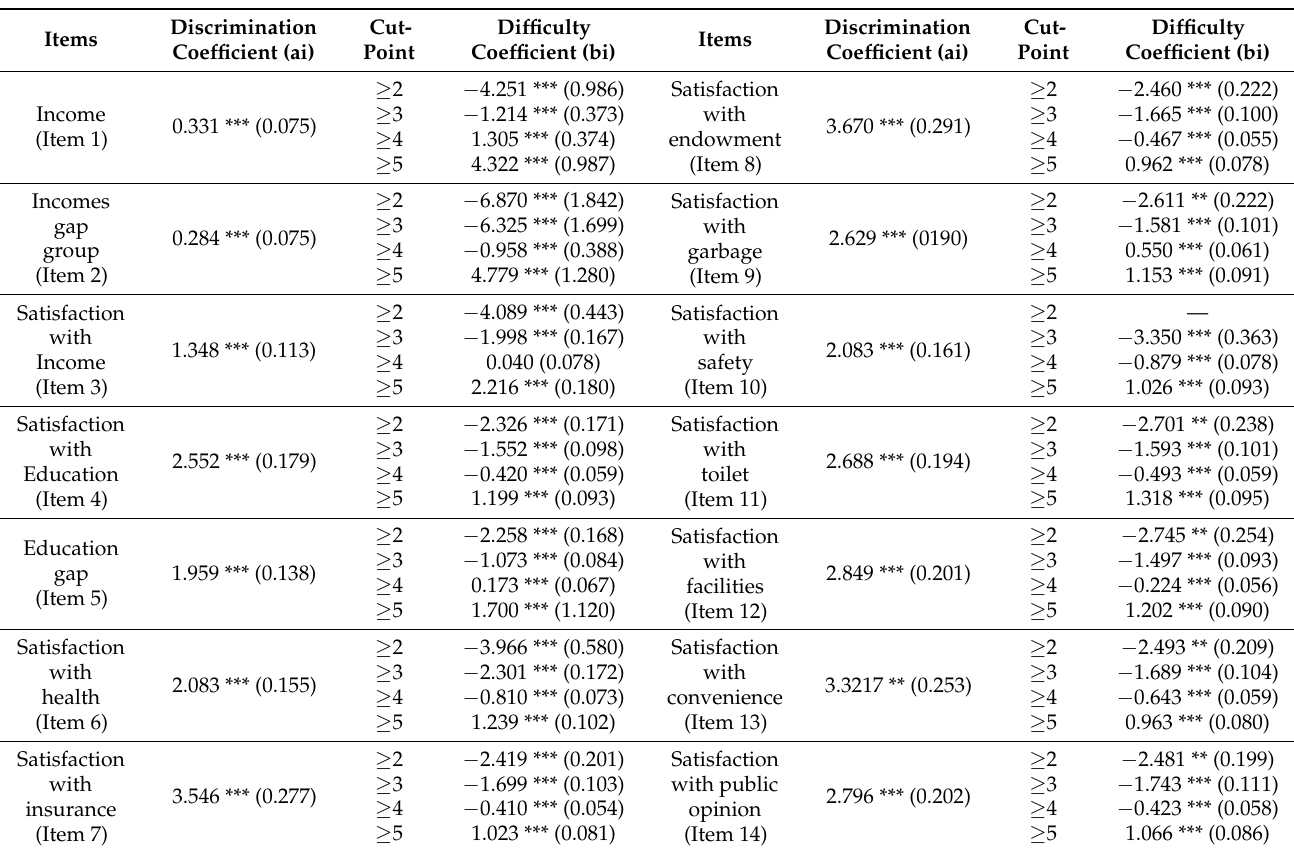
Table 3. Parameter estimation results of GRM.